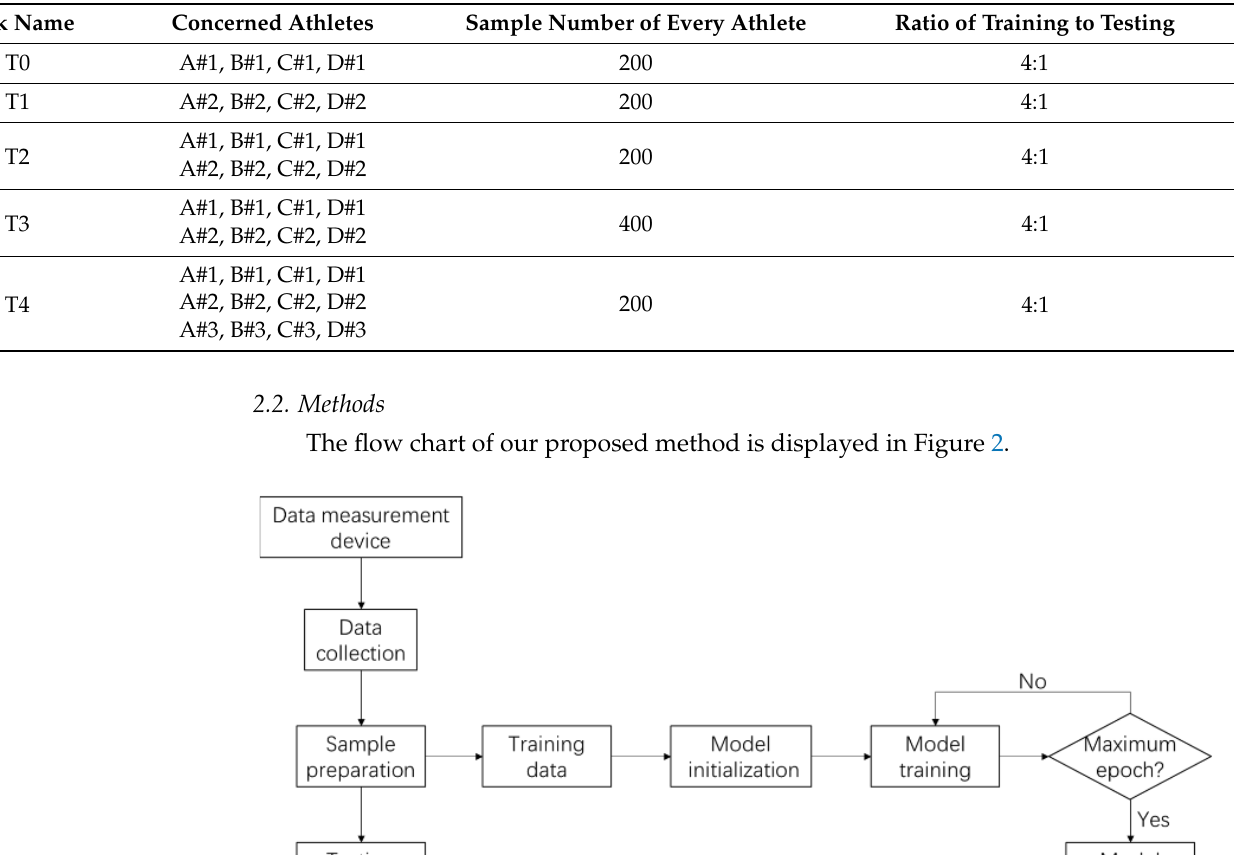
Table 2. Information for the different athlete balance control ability evaluation tasks used in this study.